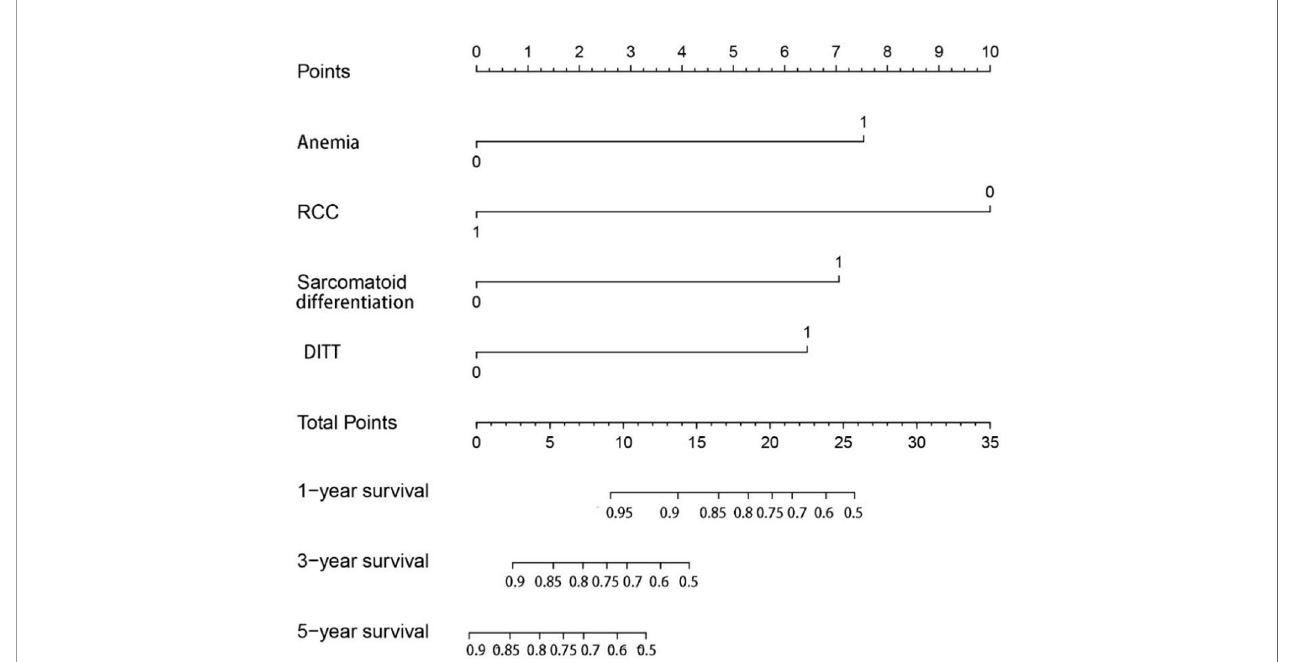
FIGURE 3 | The nomogram can predict the 1-year, 3-year, and 5-year overall survival of patients with renal cell carcinoma with tumor